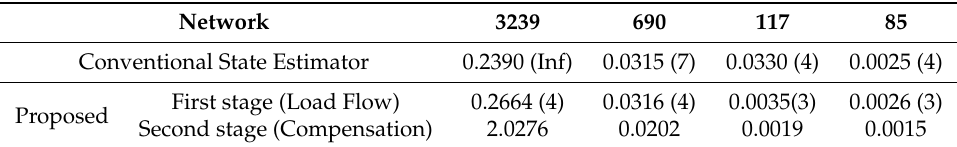
Table 3. Execution time per iteration